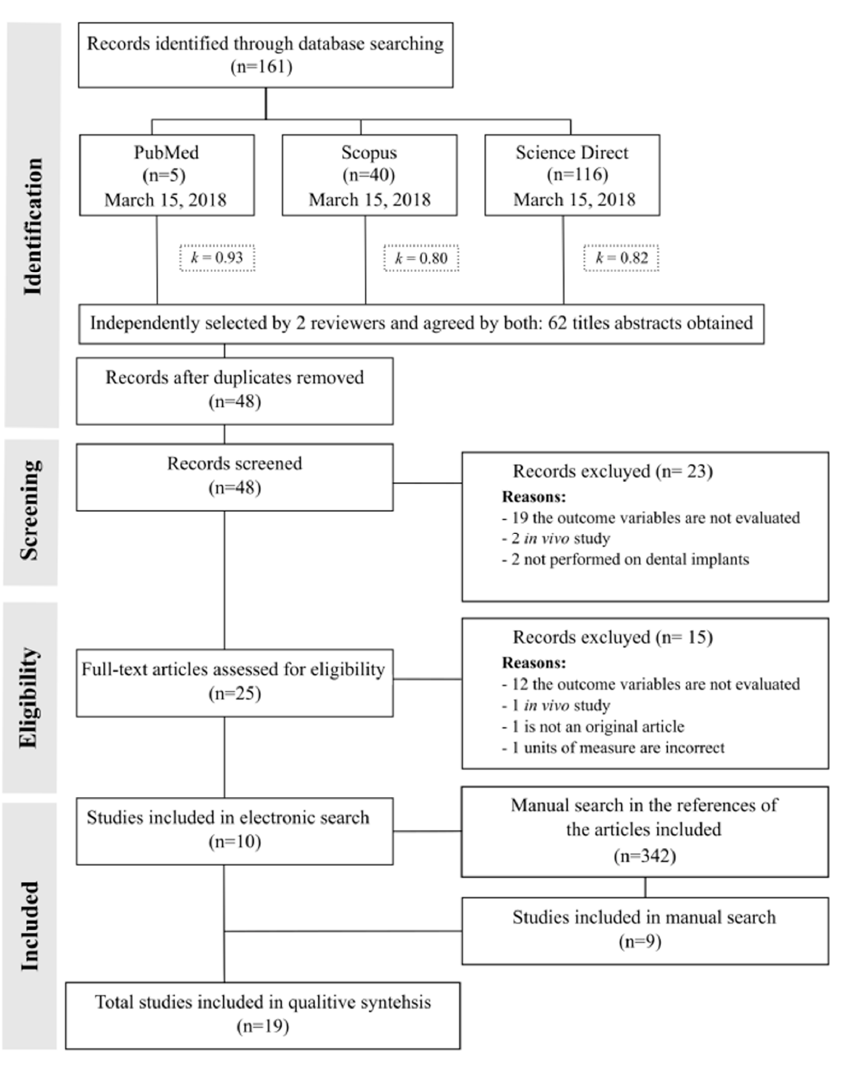
Figure 2. Flow chart.